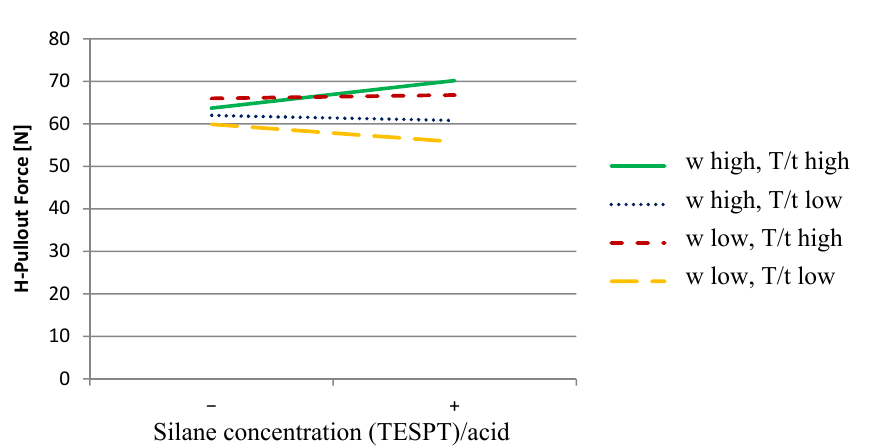
Figure 9. Effect of TESPT and acid content in the dip on adhesion. (w: water content, T/t: temperature/time).